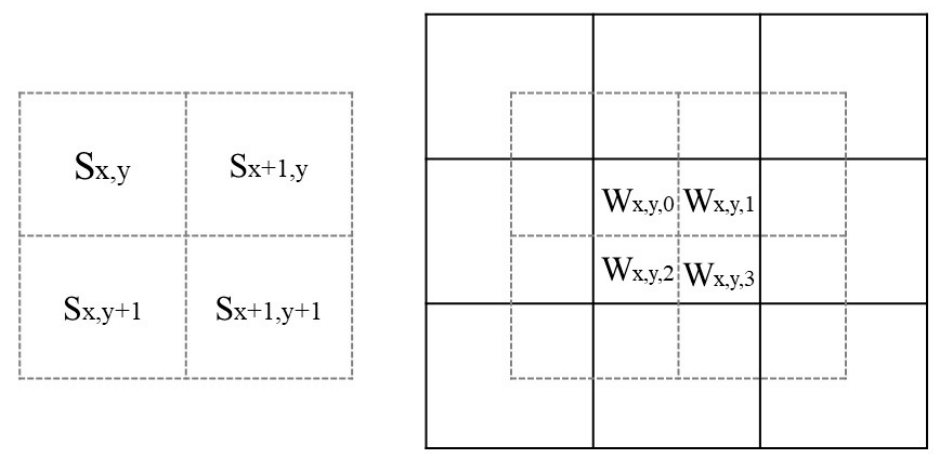
Figure 1. Values (S) are shared between neighbor pixels and combined by weights (W) to form the high-resolution pixels. The black solid line represents the distribution of high-resolution pixels, and the gray dotted line represents the distribution of shared values across pixels.